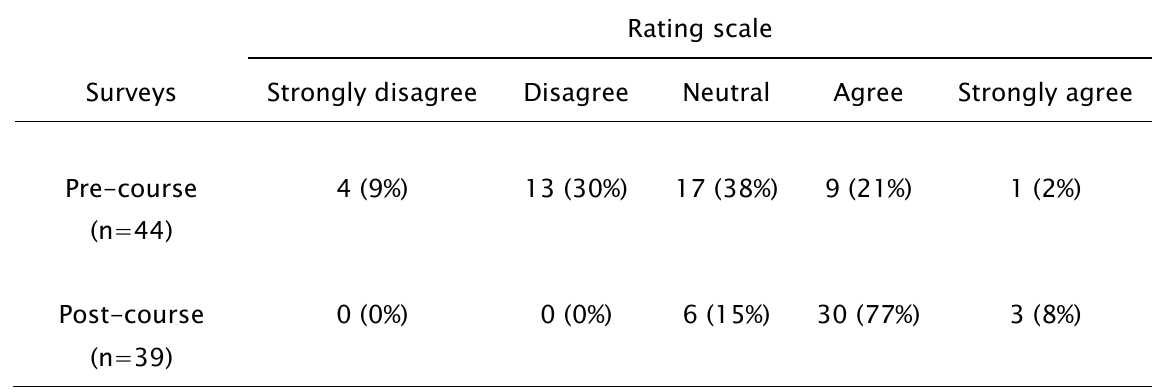
Teacher Candidates’ Responses to the Statement, “I am knowledgeable about FNMI histories, cultures, and/or